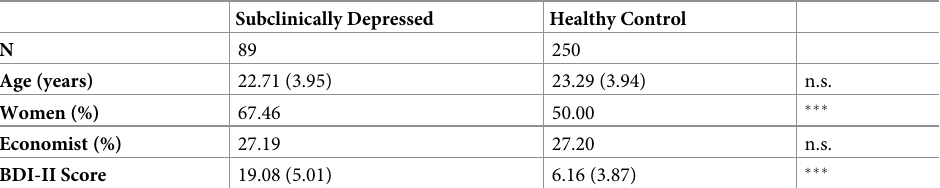
Table 2. Demographic and clinical characteristics of subclinical sample.